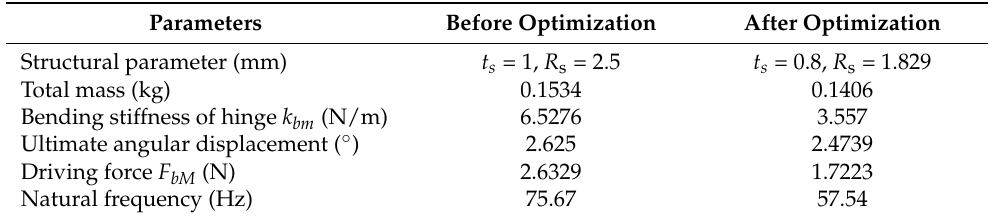
Table 4. Comparison of the structural parameters of flexible spherical hinge and dynamic perfor- mance before and after optimization.